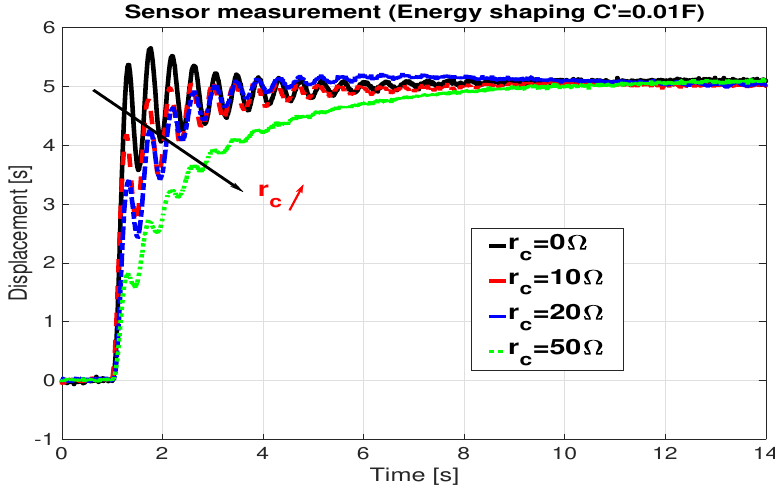
Figure 6. Closed loop response with IDA-PBC and damping injection.